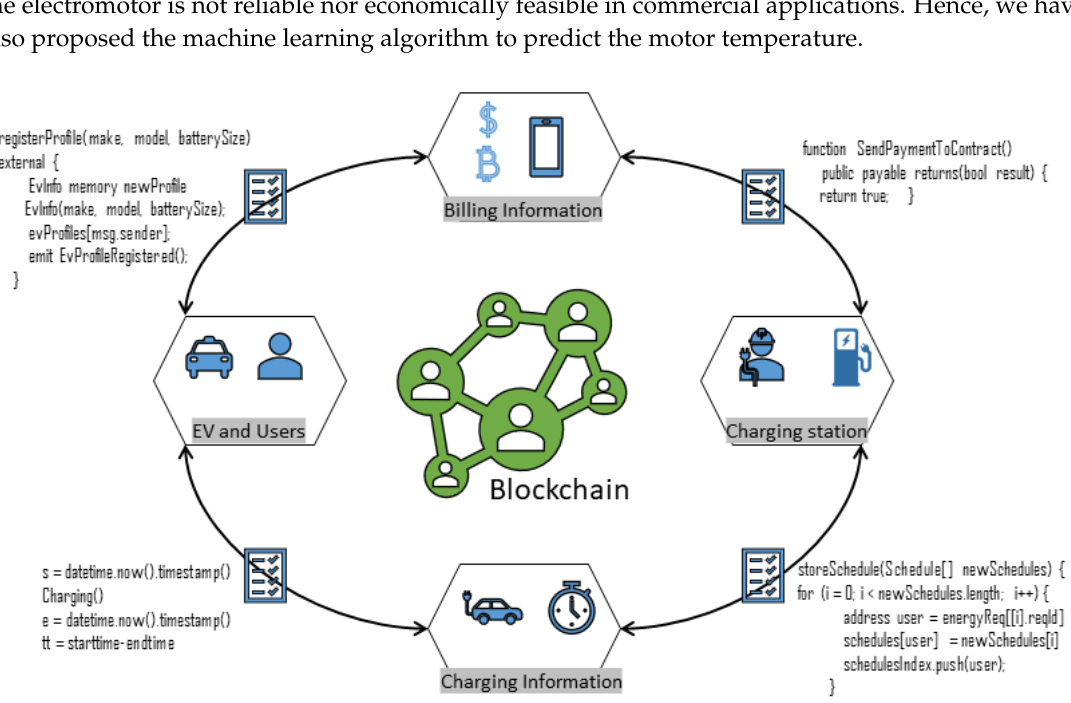
Figure 1. Integration scenario for different actors of blockchain based